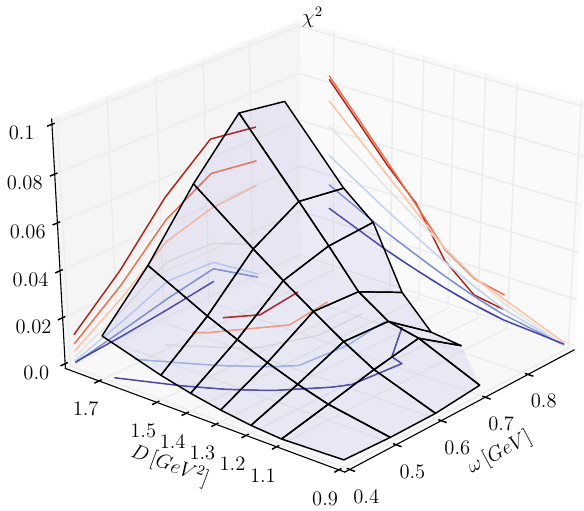
Fig. 2 Hyperfine splitting between π and ρ masses